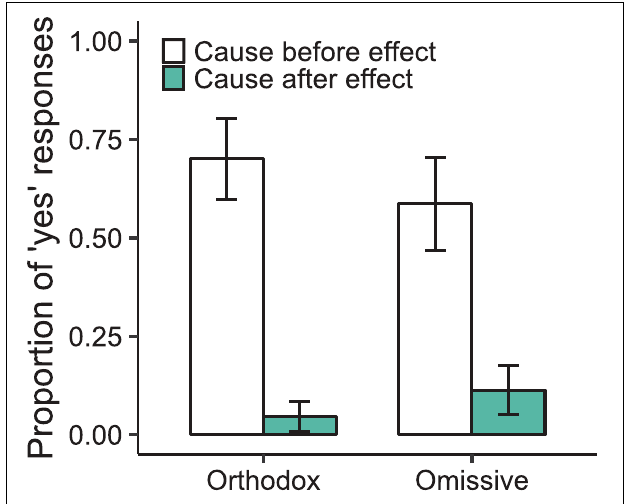
FIGURE 1 | Proportions of “yes” responses in Experiment 1 as a function of whether the causal relation concerned an orthodox or an omissive cause and as a function of whether the temporal relation evaluated described a cause that occurred before or after the effect. The balance of responses in the study were either “No” or “Don’t know for